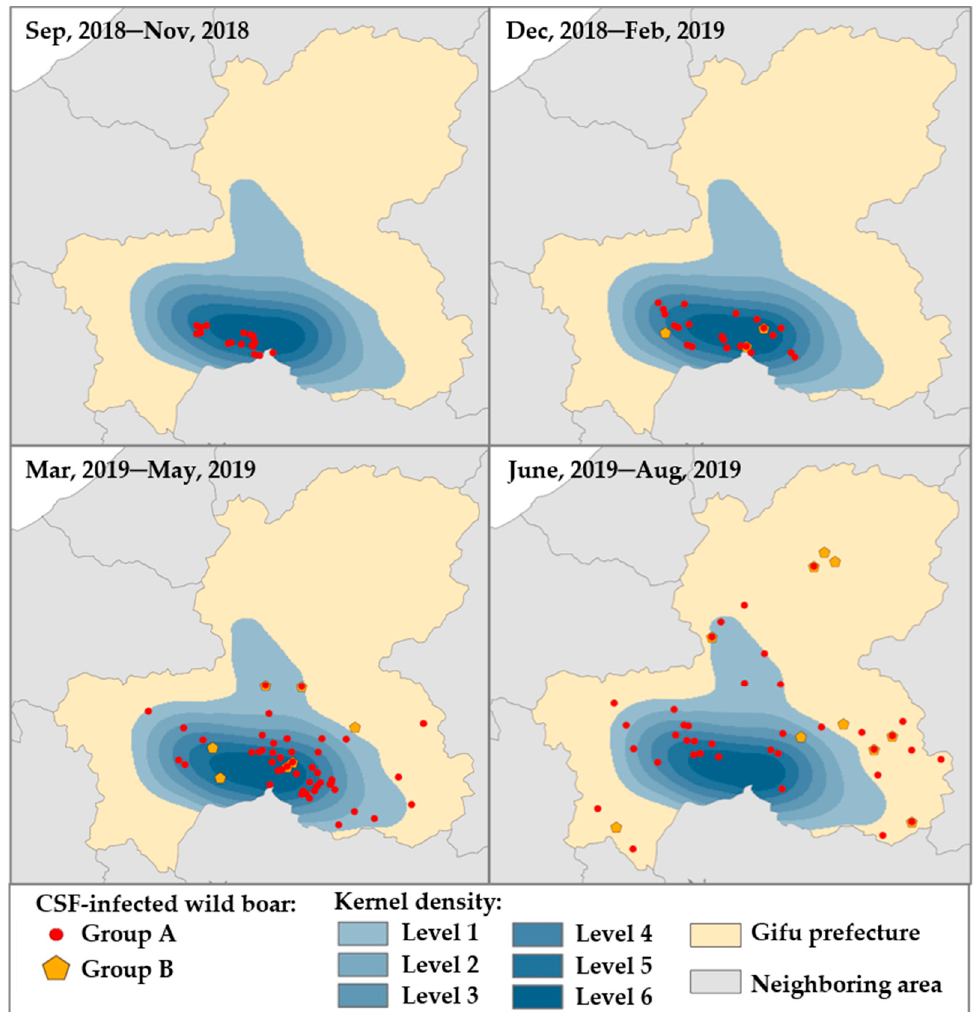
Figure 4. Dynamics of two groups of wild boars classified as a potential natural reservoir of CSFV among wild boar population. The illustration of Groups A and B was arranged for 4-time courses, as shown on the map. The heat map indicated the estimated kernel density for Group A (red circle) as one epicenter from high density (dark blue, level 4–6) to low density (light blue, level 1–3). Group B (yellow pentagon) was illustrated in the geographical map for the same period.